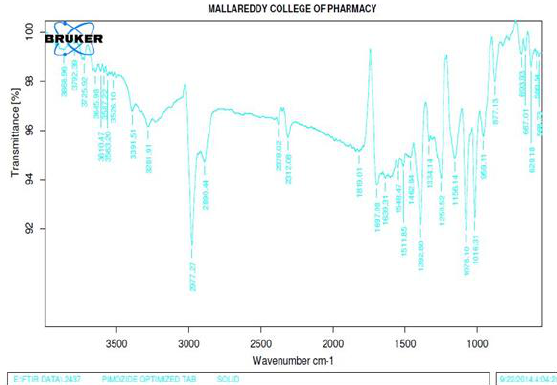
Figure 2. IR Spectra of pimozide and physical mixture with